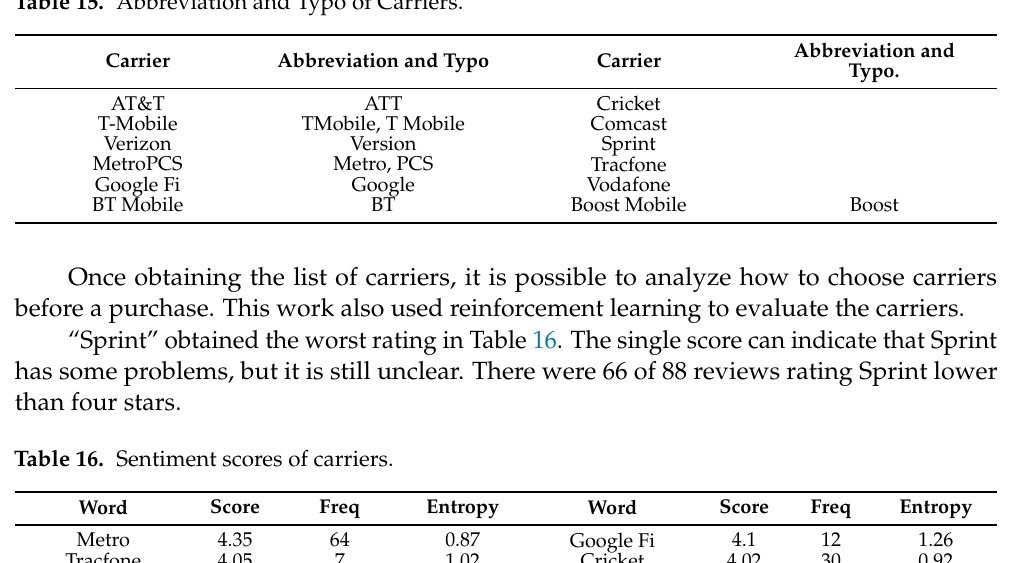
Table 15. Abbreviation and Typo of Carriers.